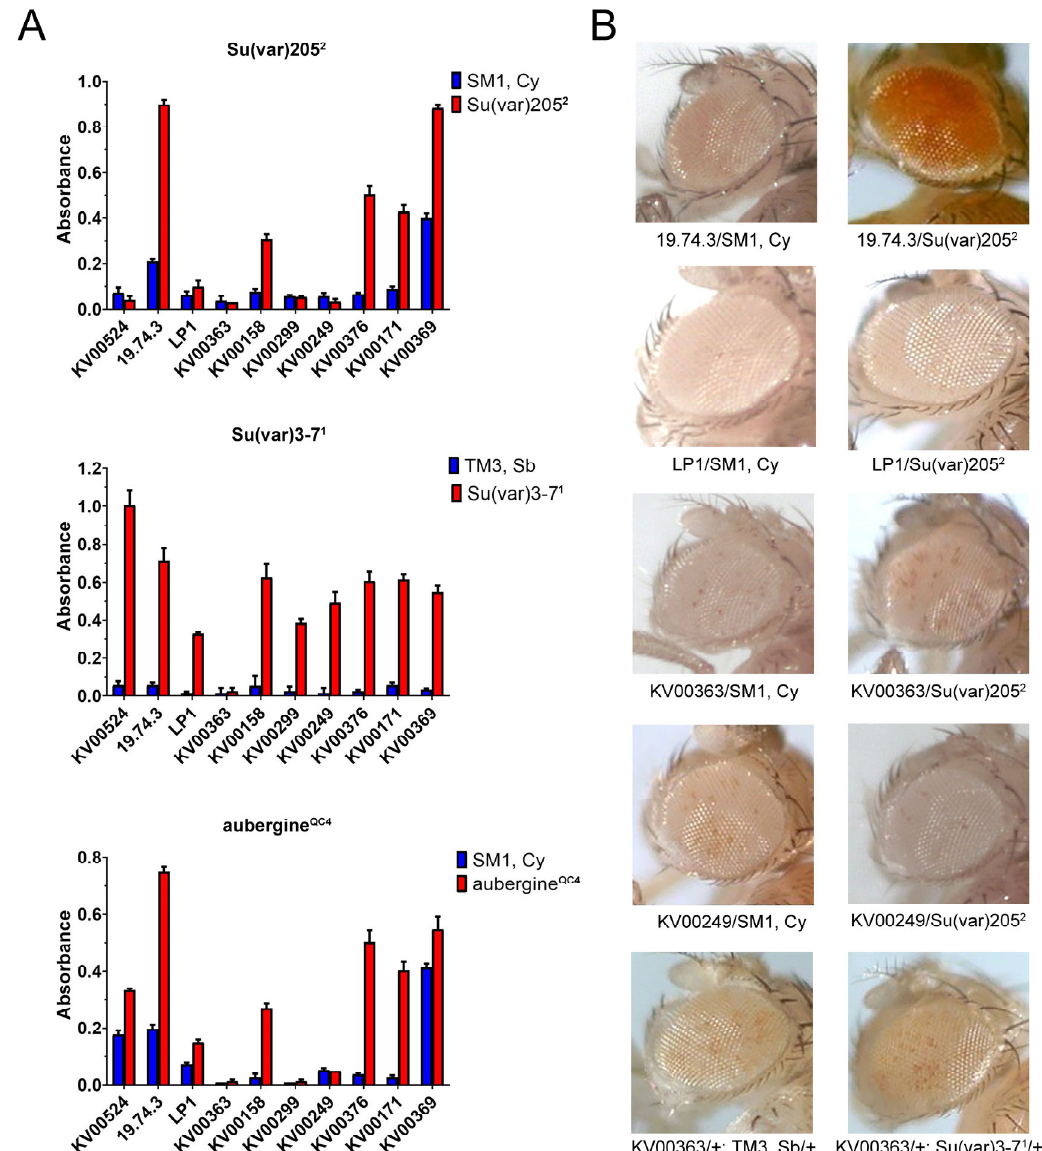
Figure 4. Effects of dominance of Su(var)205 2 , Su(var)3 ‐ 7 1 and aubergine QC4 on the silencing of Pw + reporters. ( A ) Histograms summarizing the quantification of eye pigment in presence and absence of PEV suppressors; ( B ) Examples of eye phenotypes of Pw + reporters in flies with or without suppressors. The silencing of Pw + reporter in 19.74.3 line was efficiently suppressed by Su(var)205 2 , Su(var)3 ‐ 7 1 and aubergine QC4 ; silencing in KV00363 and LP1 lines was unaffected by Su(var)205 2 and aubergine QC4 , while silencing in LP1 was only partially suppressed by Su(var)3 ‐ 7 1 . The product of the wild-type Su(var)205 gene, the heterochromatin-associated HP1 protein, interacts with the histone methyltransferase (HMTase) encoded by the wild-type Su(var)3-9 gene. The SU(VAR)3-9 methyltransferase selectively methylates histone H3 at